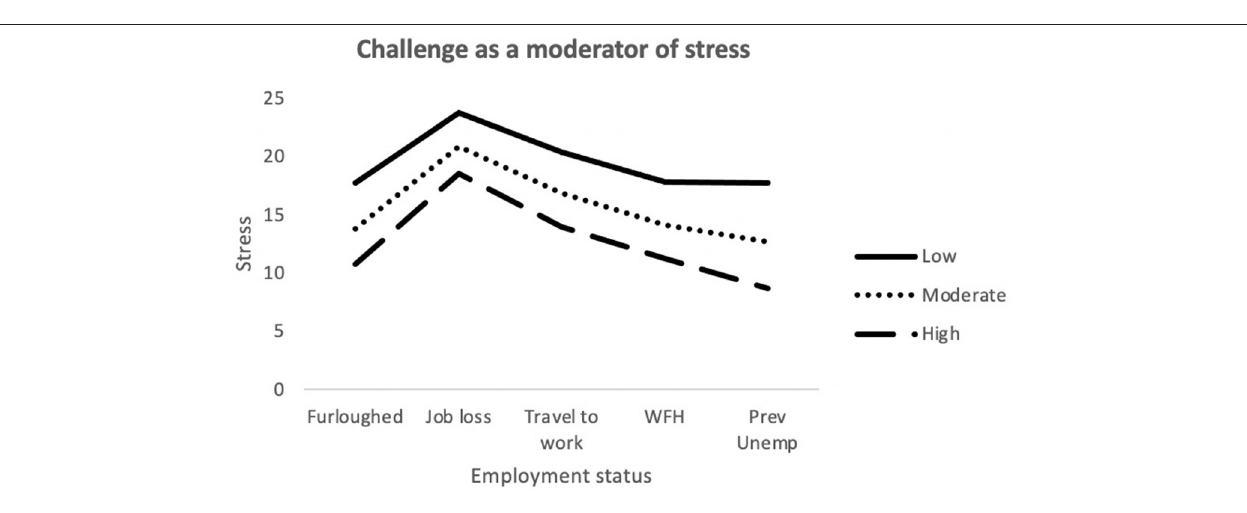
FIGURE 4 | Interaction between job outcome and Challenge for Stress. WFH, Employed (working from home); Prev Unemp, previously